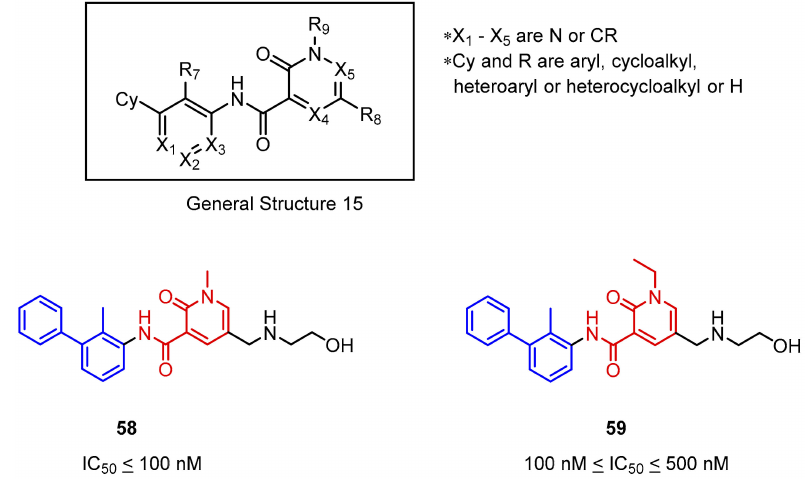
Figure 25. General structure and examples of the PD-1 / PD-L1 inhibitors ( 58 and 59 ) reported by Incyte